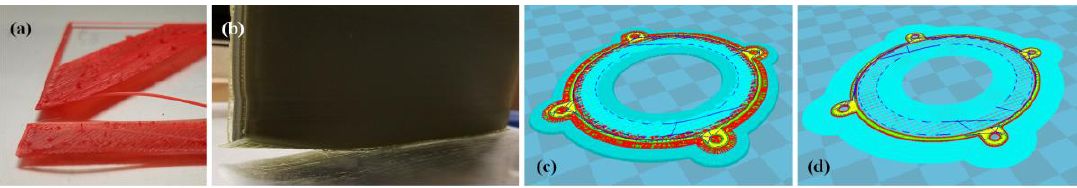
Figure 2. Print bed issues in FDM. ( a , b ) Poor adhesion and ( c , d ) Cura ® calculation of raft and brim for example part. All cases show ABS printed on heated tempered glass.